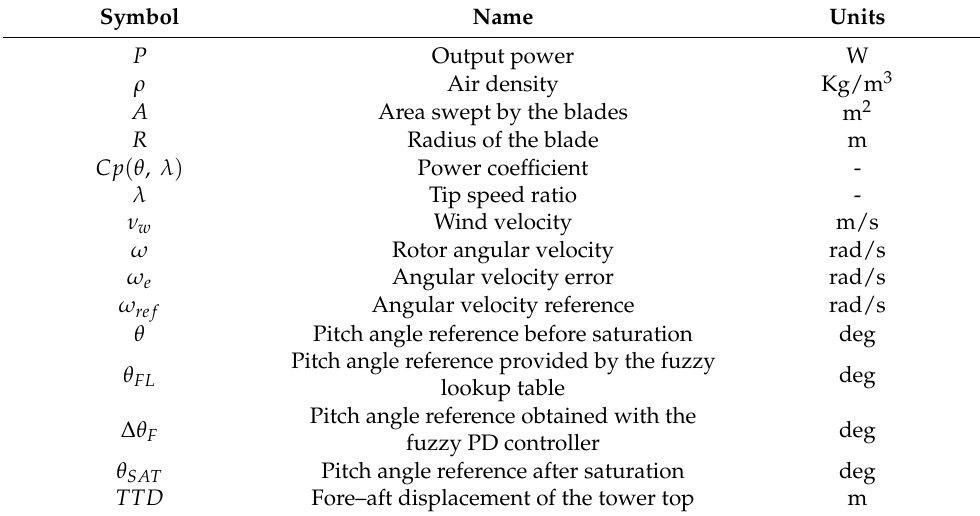
Table 1. List of parameters and